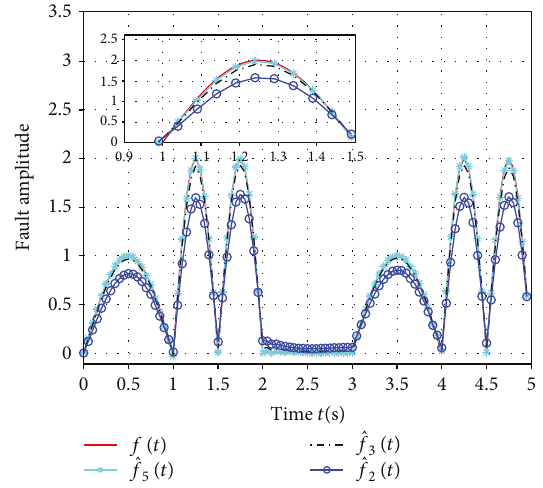
Figure 5: The tracking trajectory of slow variation fault for a nonlinear system with time-varying parameter uncertainties.